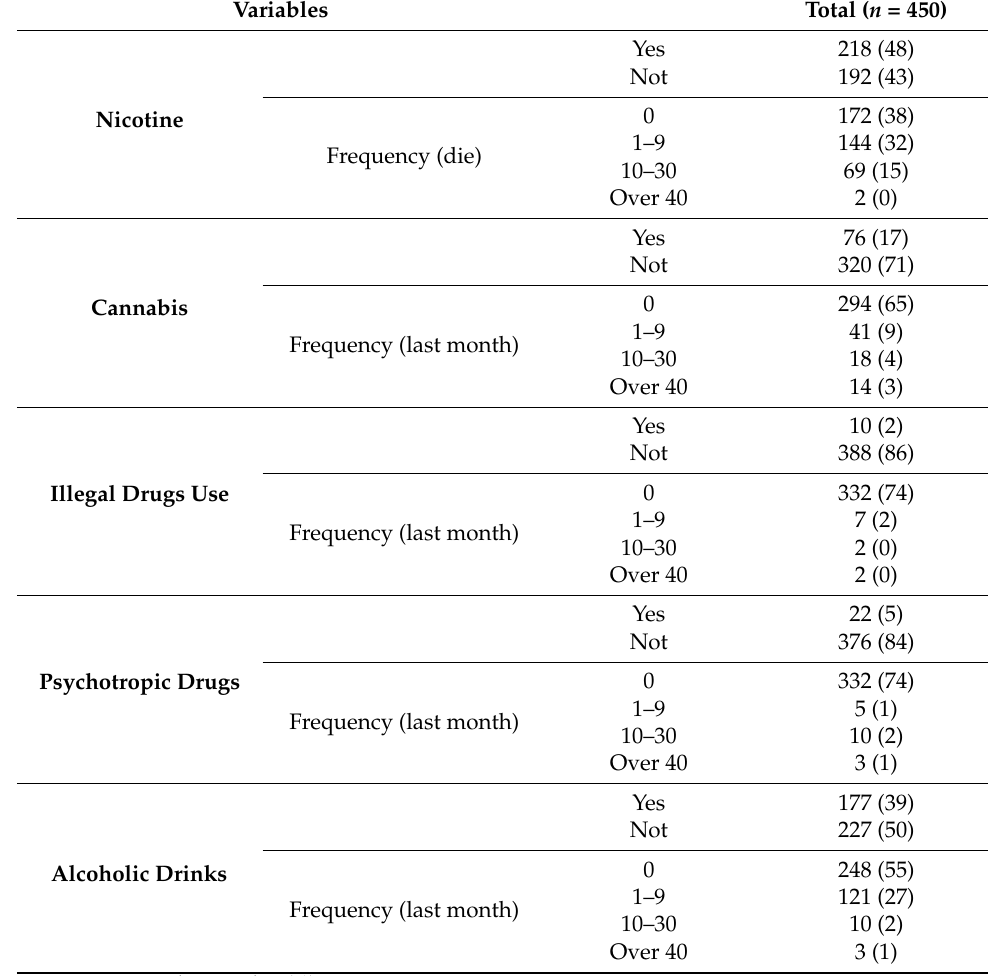
Table 1. Frequency of substance use and abuse in total population.